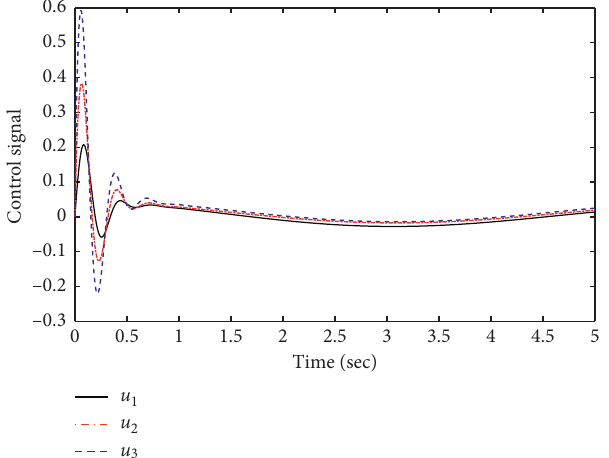
Figure 6: Control signal of the system under matched uncertainty.